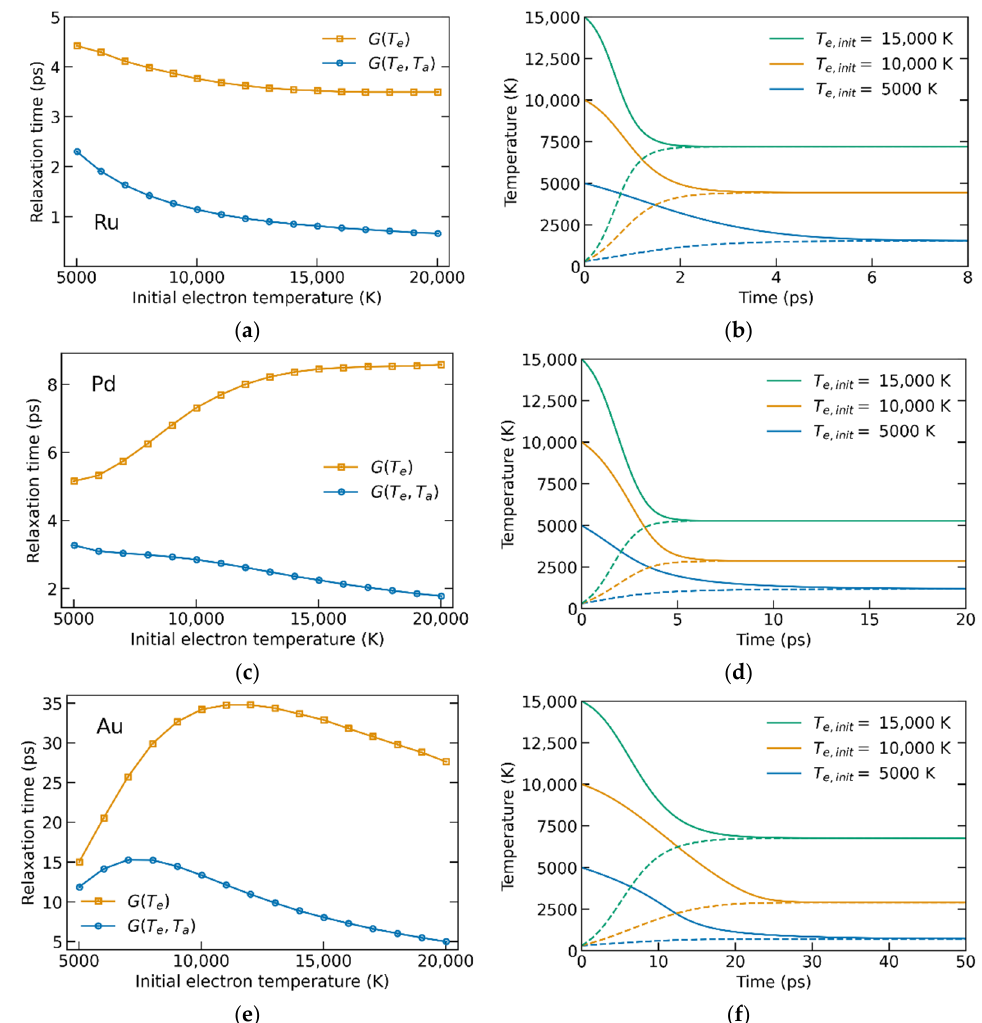
Figure 4. ( a , c , e ) Electron–ion relaxation times, calculated using both electronic- and atomic-temperature-dependent coupling (blue) and only electronic-temperature-dependent coupling (orange). ( b , d , f ) Examples of T e - and T a -profiles calculated using G(T e ,T a ) for different starting electronic temperatures; solid lines are the electronic temperatures, and dashed lines are the ionic ones. ( a , b ) correspond to Ru, ( c , d ) to Pd, ( e , f ) to Au.